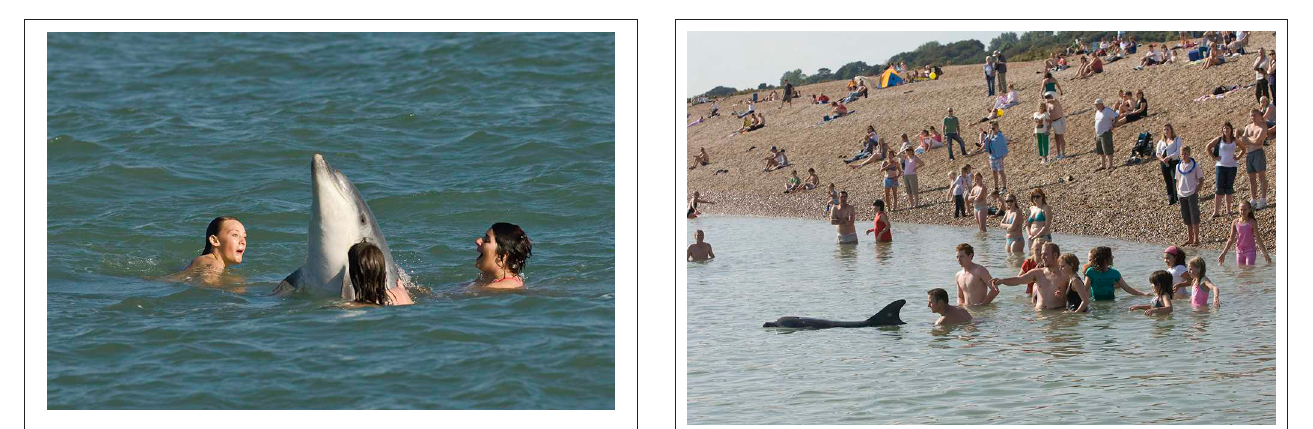
It is distinguished from Wilke et al.’s Stage 1 animal that has established a home range.